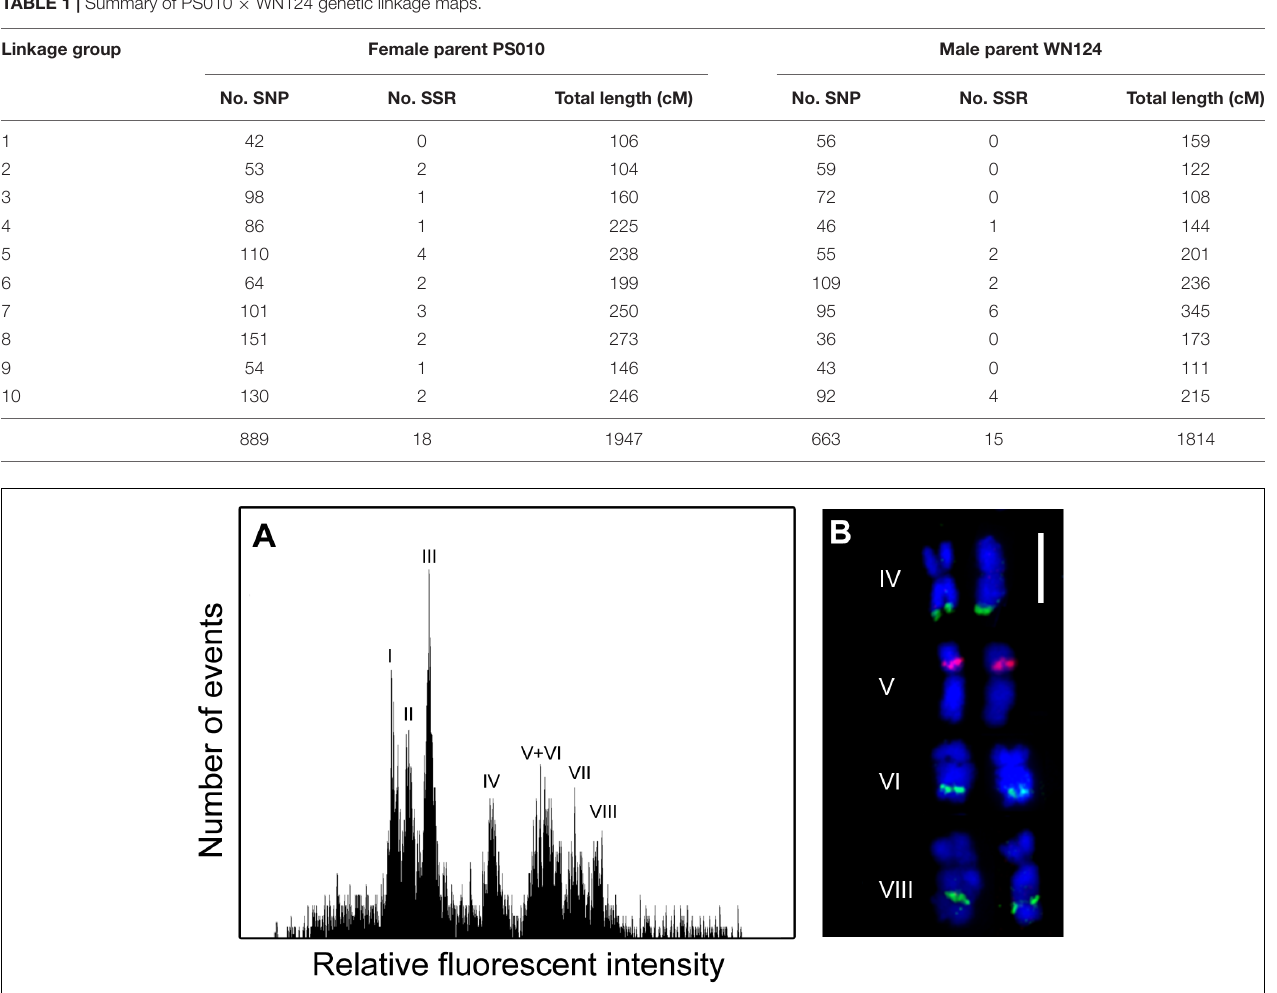
FIGURE 1 | Flow cytometric chromosome analysis and sorting in garden asparagus ( Asparagus officinalis , 2 n = 2 x = 20). (A) Histogram of relative fluorescence intensity (flow karyotype) obtained after the analysis of DAPI-stained chromosomes. Eight major peaks (I–VIII) could be resolved. (B) Examples of chromosomes sorted from peaks IV, V, VI, and VIII. The chromosomes were identified after fluorescence in situ hybridization/FISH with probe for 45S rDNA (green) and 5S rDNA (red) loci. The chromosomes were counterstained with DAPI (blue). Scale bar: 5 µ